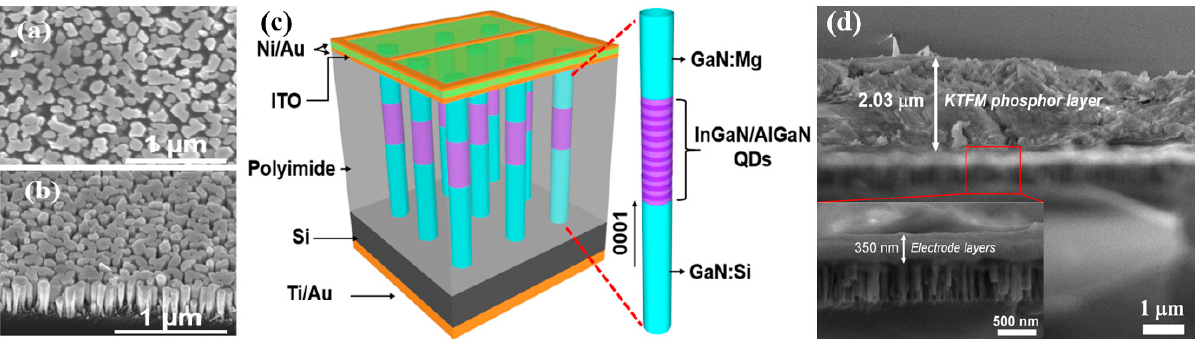
Figure 3. SEM images of the ( a ) top-view and ( b ) 45° tilted angle of a typical InGaN/AlGaN nanowire WLED. ( c ) Schematic illustration of the nanowire-WLED device with anode and cathode electrodes. The schematic structure of a single nanowire WLED is also presented. ( d ) SEM images of the nanowire WLEDs with KTFM nanophosphor layer. The inserted picture shows the electrode layer on the top of the nanowire WLED.